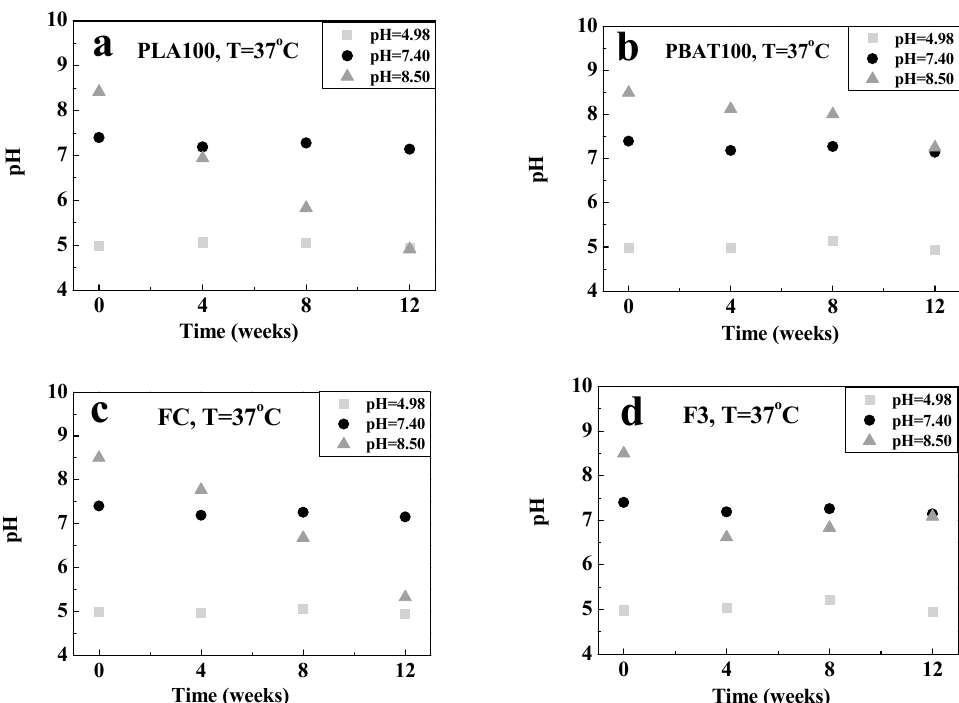
Figure 9. Variation in the pH of the buffer solutions used for degradation at 37 °C with time for: ( a ) PLA100, ( b ) PBAT100, ( c ) FC, and ( d ) F3.